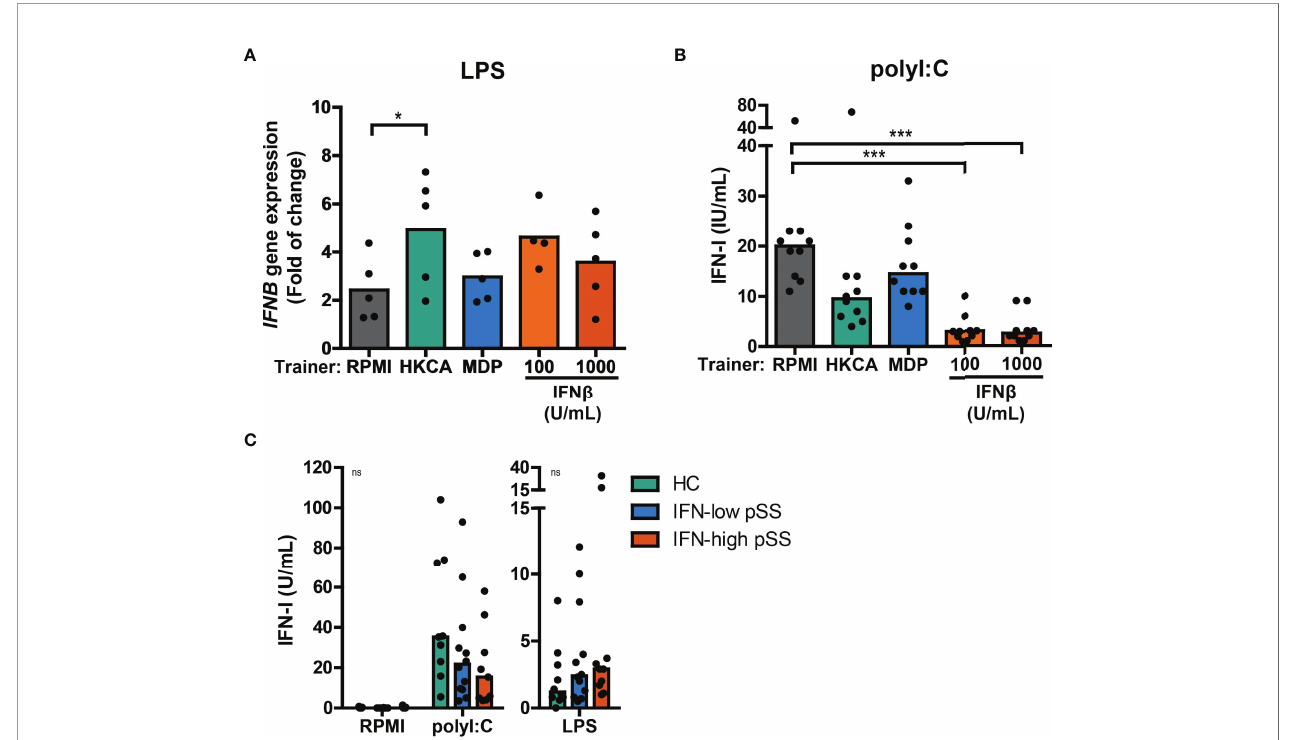
FIGURE 4 | Training with HKCA en MDP induce differential type I IFN response upon re-stimulation. (A) Relative mRNA expression (2 DD CT ) of IFNB in THP-1 cells trained with heat-killed Candida albicans (HKCA; 10 6 cells/mL), muramyl dipeptide (MDP; 50 µg/mL) or IFN b and re-stimulated with 1 µg/mL LPS + 10% fetal calf serum for 24 hours. Fold change expression was calculated relative to the corresponding unstimulated control. (B, C) Type I IFN bioactivity quanti fi ed by the HEK IFN- a / b reporter cell assay in culture supernatants of (B) HKCA-, MDP- and IFN b -trained THP-1 cells re-stimulated with 5 µg/mL poly I:C for 24 hours or (C) PBMCs from pSS patients strati fi ed based on blood ISG expression and healthy controls (HC) stimulated with 5 µg/mL poly I:C or 10 ng/mL LPS for 24 hours. Symbols indicate the average of duplicates (C) or triplicates (A, B) and bars represent means or medians. Friedman test or repeated measures ANOVA was performed to compare groups. ns: not signi fi cant, *p<0.05,